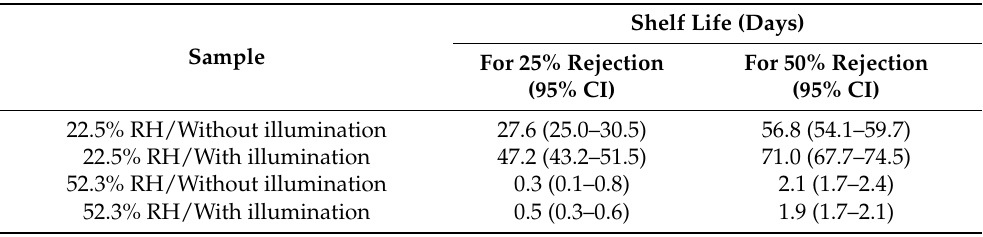
Table 4. Estimated sensory shelf life values of the strawberry leather during storage for 25% and 50% consumer rejection, and their 95% confidence intervals